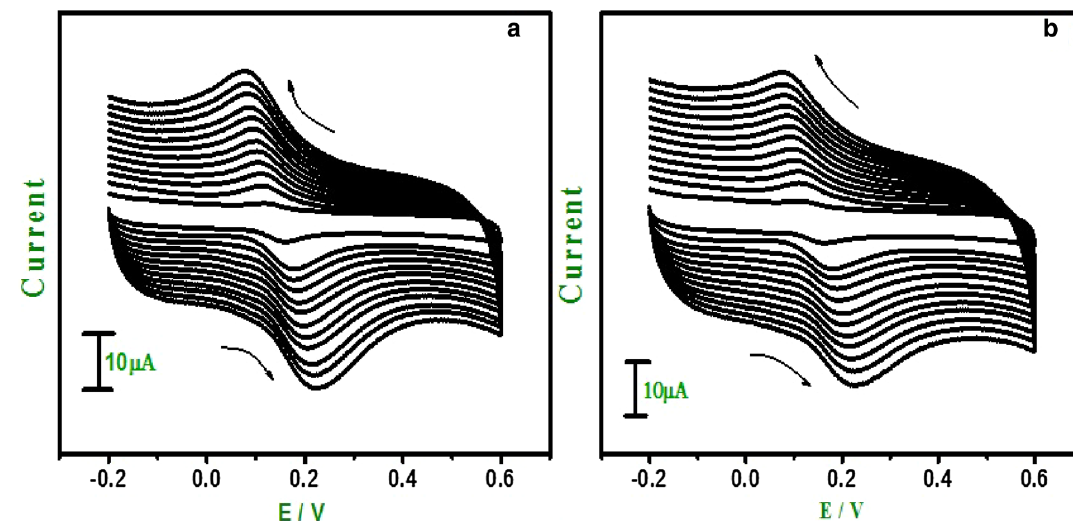
Figure 7. Cyclic voltammograms of 0.02 mM DA at ( a ) GO modified CPE ( b ) E-GO modified CPE in 0.2 M phosphate buffer solution at pH 7.0 with sweep rate variation (0.05–0.38 Vs −1 ).